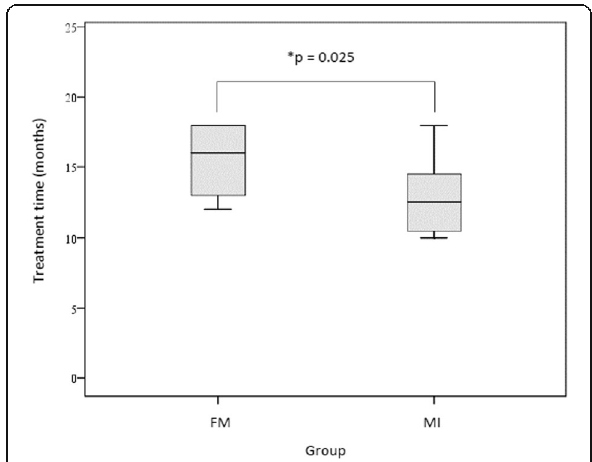
Fig. 5 Time of treatment according to the groups. Height of the rectangle represents the first and third quartiles; the line that sections the rectangle represents the median; the semi-straight lines link quartiles 1 and 3 to the minimum and maximum values. **Mann-Whitney